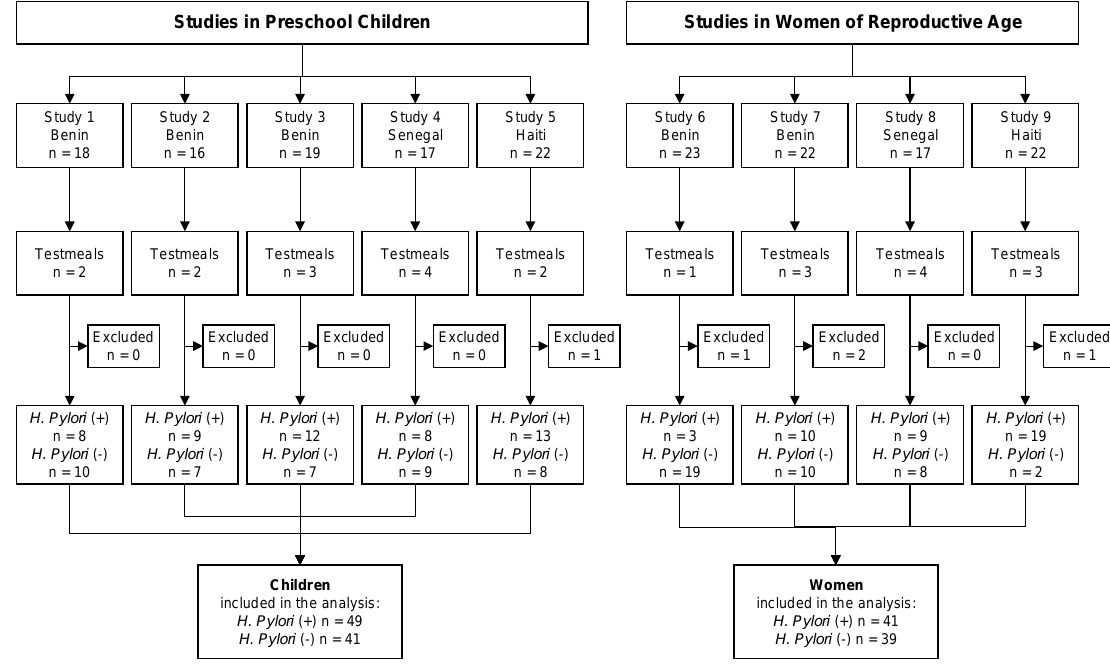
Figure 1. Study flow chart: Five iron absorption studies in preschool children and four iron absorption studies in women of reproductive age were conducted at different sites. Five participants were excluded from the analysis because Helicobacter pylori status was not assessed.